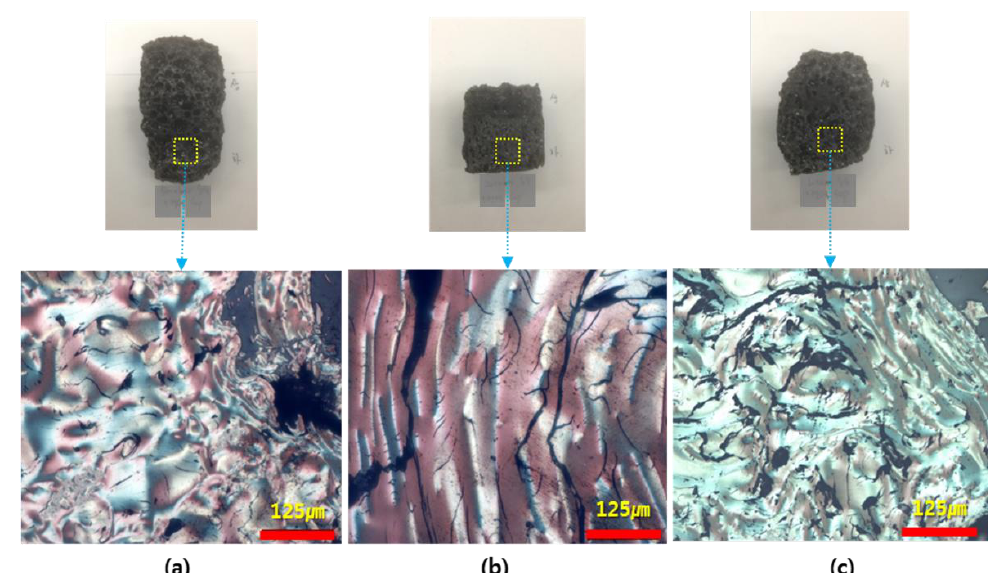
Figure 5. Morphological textures of coke specimens prepared with treated coal tar pitch. The K -factor of additives varied as 9.8–10 ( a ), 10–10.3 ( b ), and 10.3 and above ( c ).